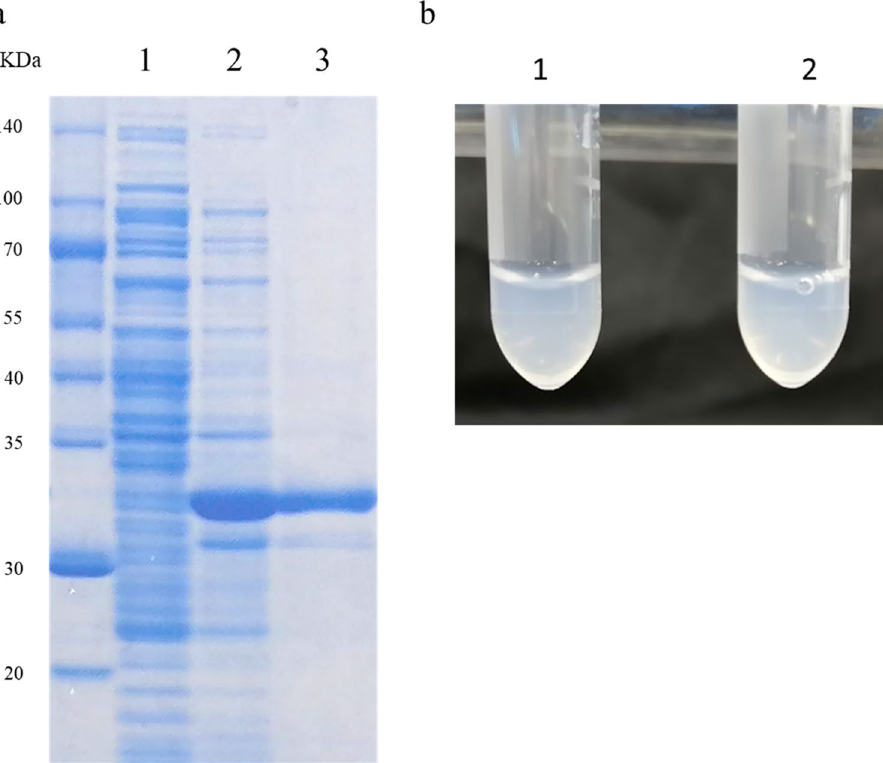
Figure 4. Expression and purification of Escherichia coli tropomyosin. ( a ) Tropomyosin from Japanese basket clam ( Corbicula japonica ) was expressed in Escherichia coli , and the protein was extracted, purified, and subjected to SDS-PAGE. (1) Protein extracted from Escherichia coli under non-induced conditions. (2) Protein extracted from E. coli under induced conditions. (3) Purified His-tag protein. ( b ) (1) His-tag purified protein extracted from E. coli. (2) His-tag purified protein extracted from E. coli boiled for 5